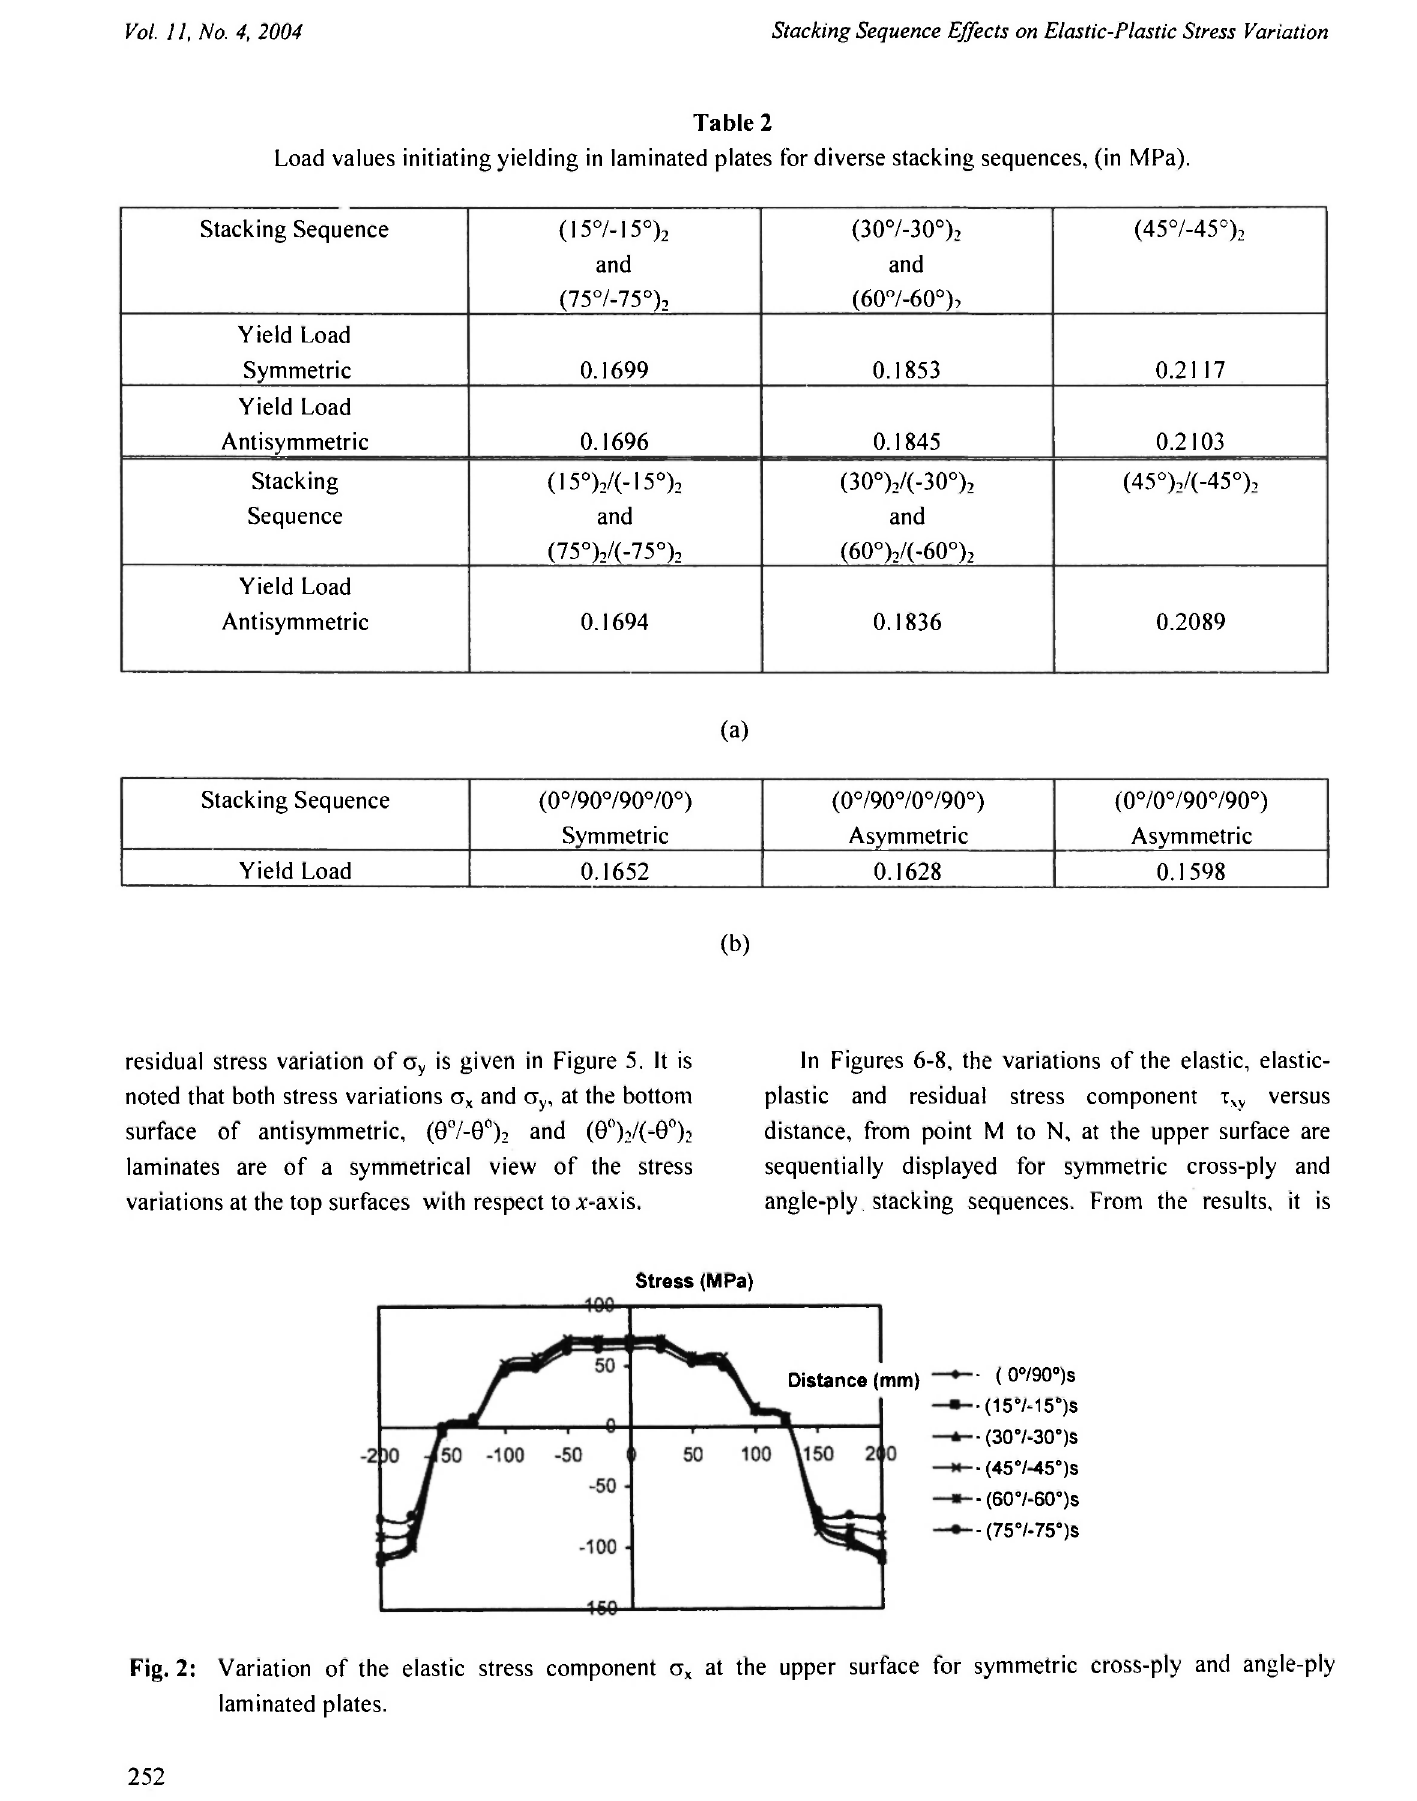
Fig. 2: Variation of the elastic stress component σ χ at the upper surface for symmetric cross-ply and angle-ply laminated